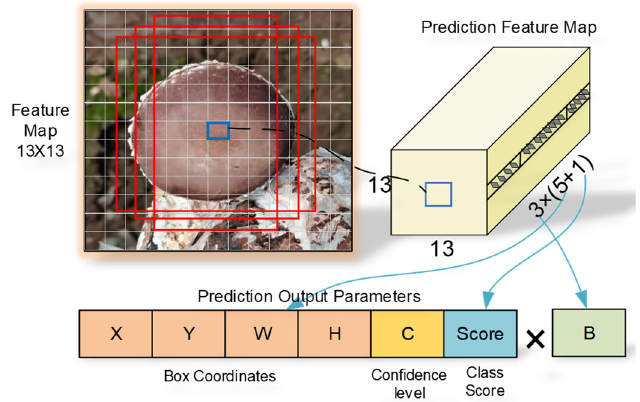
Figure 5. Structure of the 13 × 13 prediction layer.